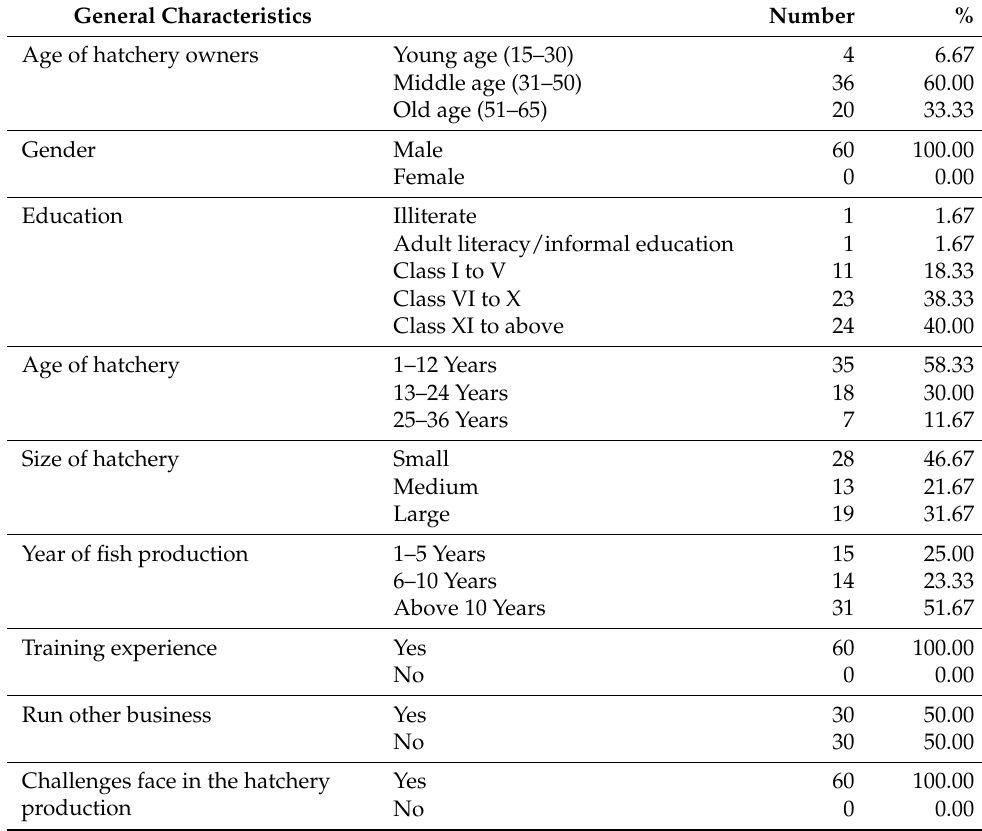
Table 1. General characteristics of hatchery owners and hatcheries.